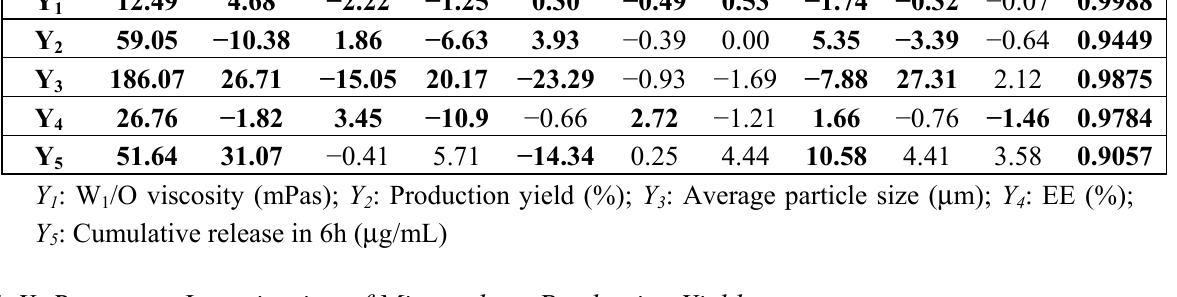
–b ) effects of the independent variables on the dependent variables 11 33